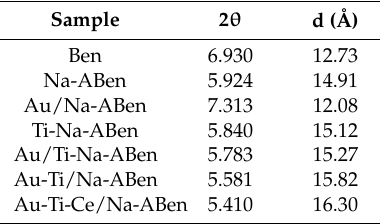
Table 2. The 2 θ and d(001) spacing of the samples.